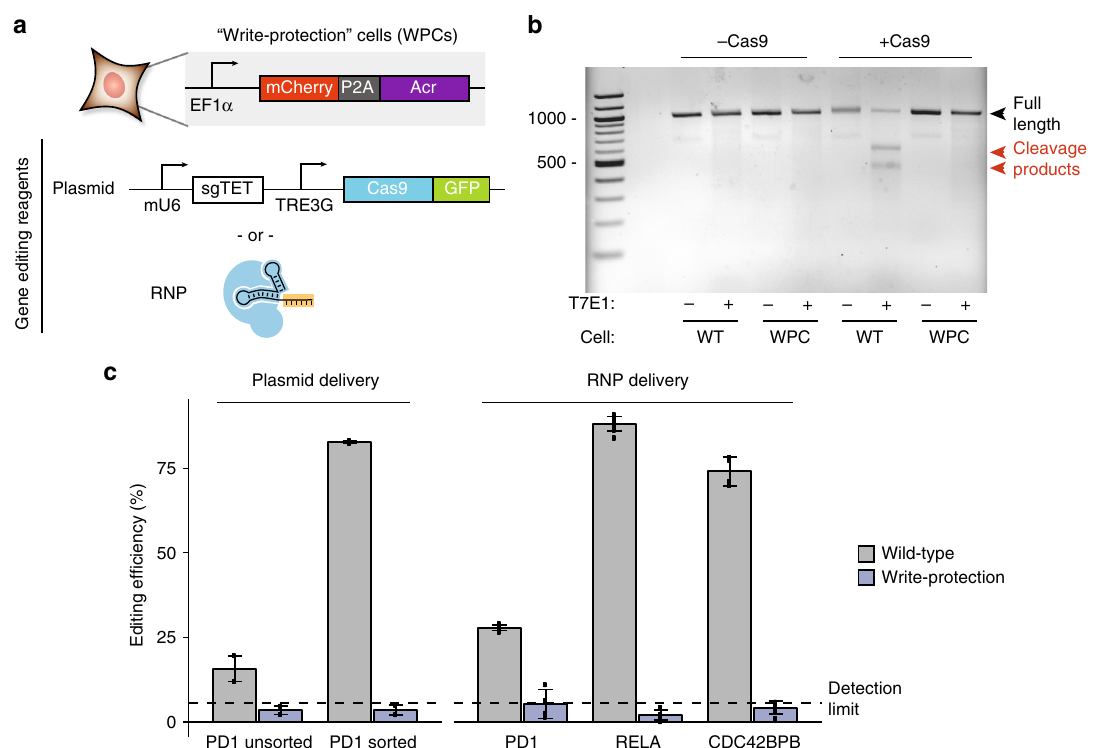
Fig. 5 Cells with integrated AcrIIA4 become “ write-protected ” against future editing. a HEK293T cells were lentivirally transduced with a cassette constitutively expressing AcrIIA4. A clonal line was isolated and compared to untransduced wild-type cells. Cas9 + sgRNA was delivered either by a plasmid expressing both components or puri fi ed ribonucleoprotein complex (RNP). b Results from a T7E1 assay comparing editing ef fi ciency between wild- type (WT) and AcrIIA4 (WPC) line targeting the PD1 locus run on an agarose gel. 100 bp standard is marked on left lane with positions of 500 and 1000 bp bands noted. Predicted lengths for uncut (996 bp) and cleaved products (437 and 559 bp) are annotated. Source Data are provided as a Source Data fi le. c Editing ef fi ciency as quanti fi ed by TIDE analysis, with plasmid delivery, unsorted (plasmid) and sorted (sorted), as well as RNP delivery at various genomic loci. Error bars indicate s.e.m. of n = 2 experimental replicates for plasmid delivery and an estimate of technical variance (s.d.) of a single experimental replicate for RNP delivery. The dotted line is an estimate of detection sensitivity computed from sequencing traces of unedited cells (mean + 2× s.d.). Source Data are provided as a Source Data fi